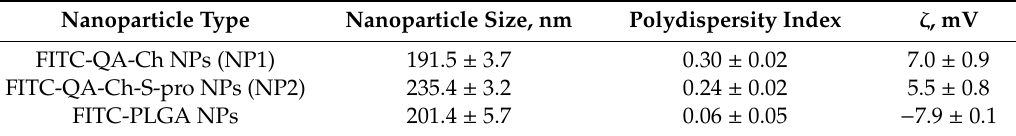
Table 1. Physical characteristics of fluorescein isothiocyanate (FITC)-labeled nanoparticles